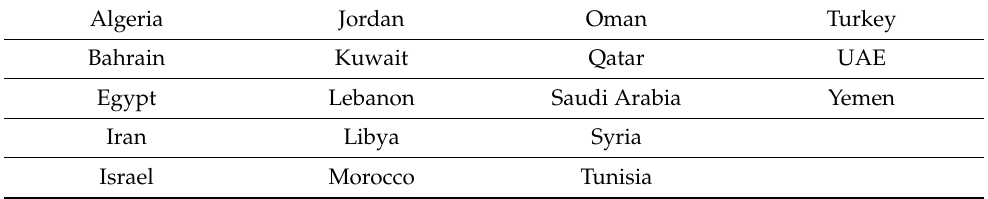
Table A5. The Middle East and North Africa (including Israel and Turkey)—18